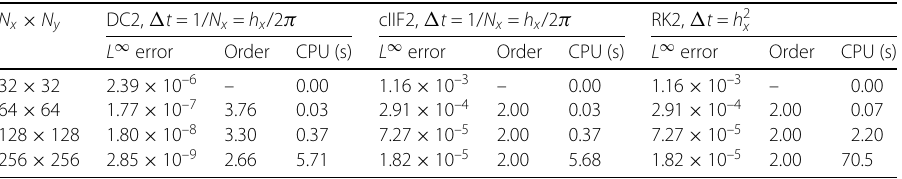
Table 1 Error, order of accuracy, and CPU time with DC2, cIIF2, and RK2 schemes for Example 1 N x × N y